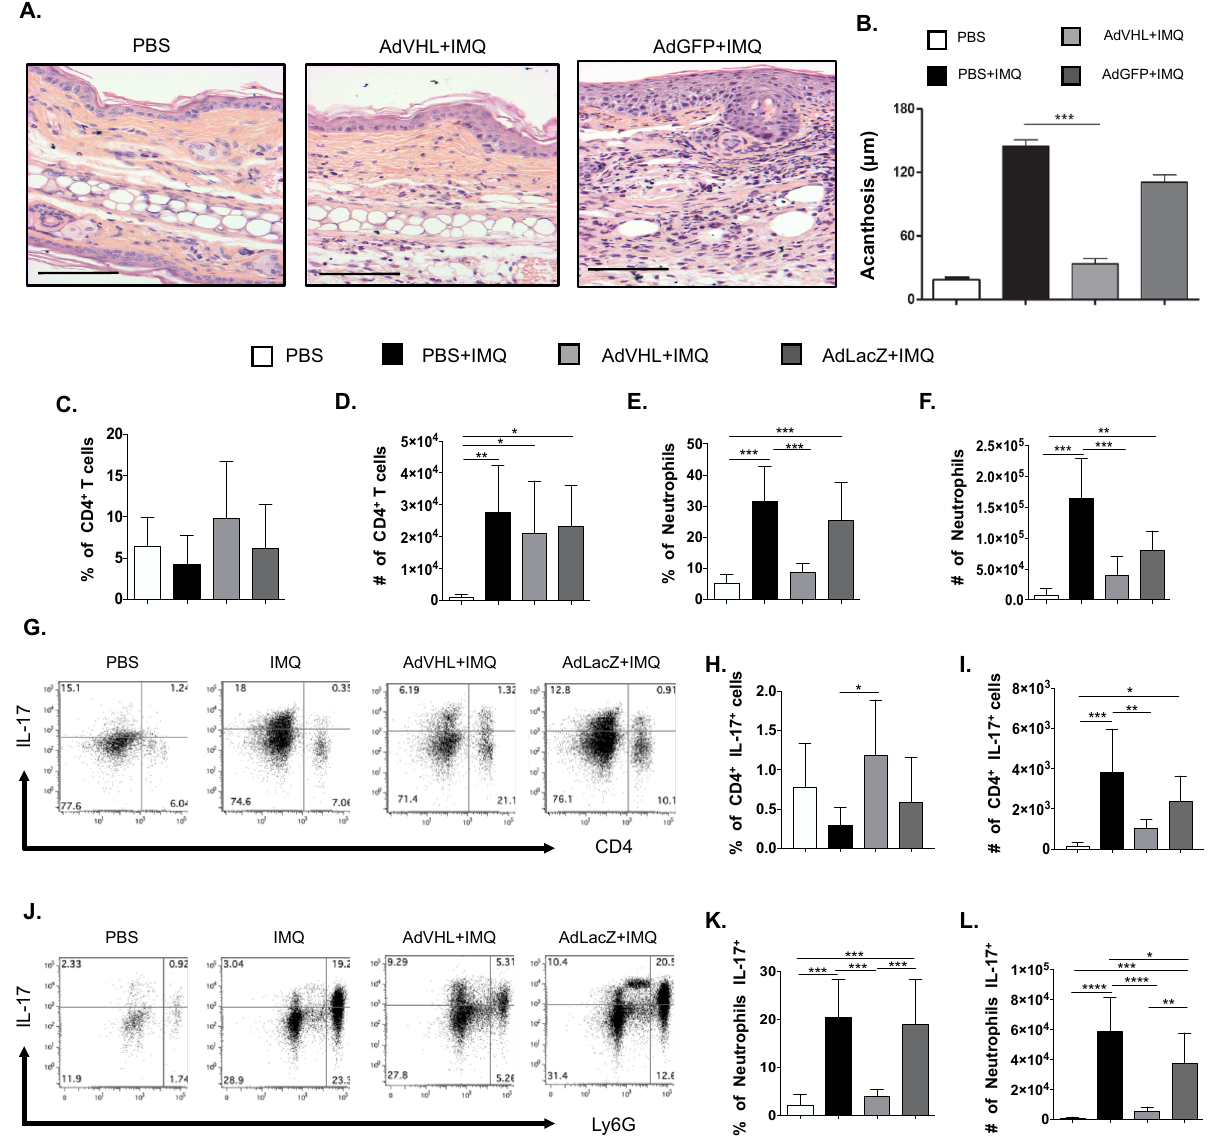
Figure 5. pVHL expression prevents the infiltration of neutrophil IL-17 producers in psoriatic skin. Psoriatic-like lesions were generated by imiquimod (IMQ) application in the ears of mice and received 1 × 10 10 PFU of AdVHL vector, as described in previous figures. ( A ) Hematoxylin–eosin staining of skin sections from mice treated with PBS, IMQ/AdVHL or AdGFP vectors. Scale bar = 100 µ m. ( B ) Bar graphs of measurements of acanthosis observed in ear skin from mice treated as mentioned above. ( C ) Bar graph of percentages and ( D ) total numbers of CD4 + T cells. ( E ) Bar graph of percentages and ( F ) total numbers of skin neutrophils. ( G ) Representative dot plots of IL-17 in CD4 + T cells (CD4 + IL-17 + ) for each treatment. ( H ) Bar graph of percentages and ( I ) total numbers of IL-17 in CD4 + T cells (CD4 + IL-17 + ) in skin. ( J ) Representative dot plots of IL-17 in neutrophils (Ly6G + IL-17 + ) for each treatment. ( K ) Bar graph of percentages and ( L ) total numbers of IL-17 in neutrophils (Ly6G + IL-17 + ) in the skin. Mean ± SD, n = 6–8, data pooled from three independent experiments. One-way ANOVA with Tukey’s multiple comparisons test. * p < 0.05, ** p < 0.01, *** p < 0.001, **** p < 0.0001. Ad: Adenoviral vector, GFP: Green fluorescent protein, IMQ: Imiquimod, IL-17: Interleukin 17, VHL: von Hippel-Lindau.